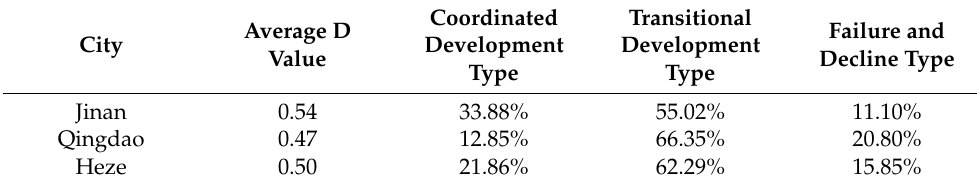
Table 5. CIS and CID coupling coordination development ratio statistics.